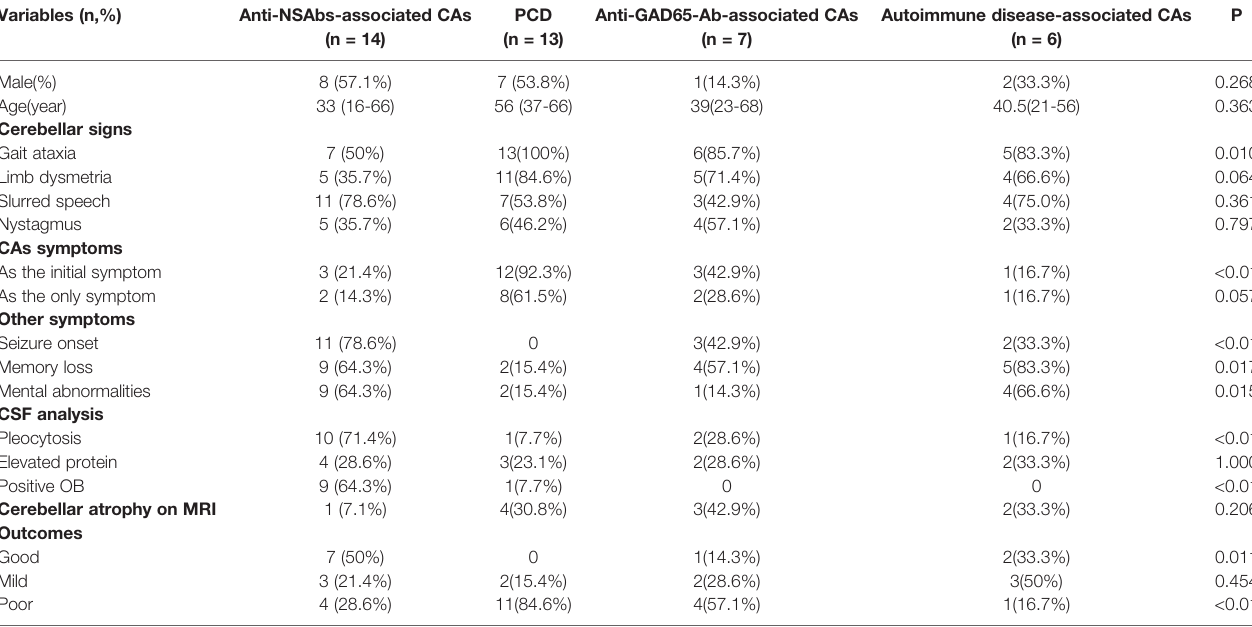
TABLE 1 | Comparison of clinical features of four forms of IMCAs.